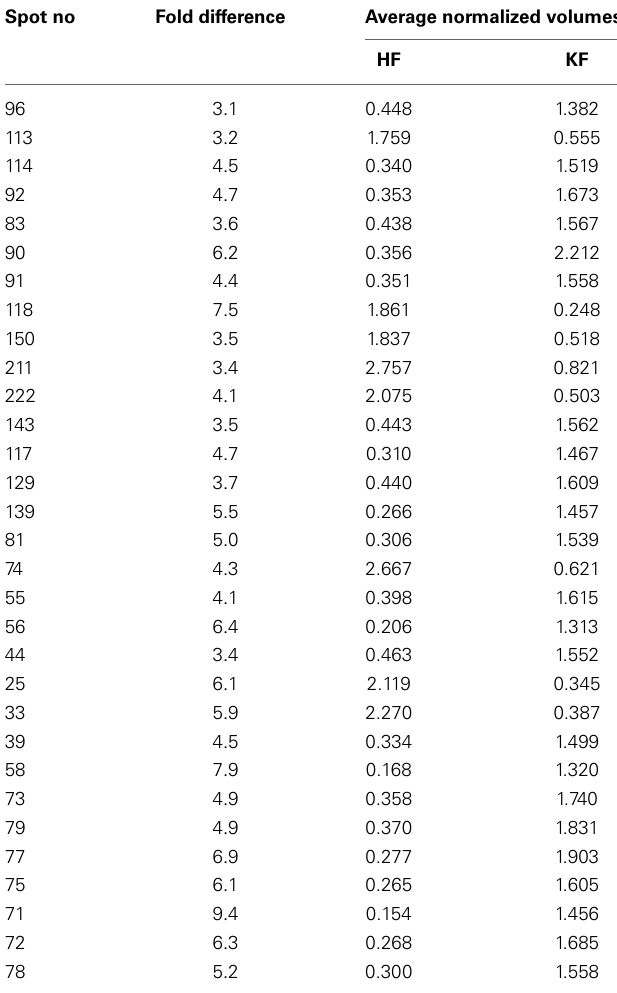
Table 3 | Differentially expressed spots in the DIGE gel of Sertoli cells (HF × KF) analyzed using the Decyder™